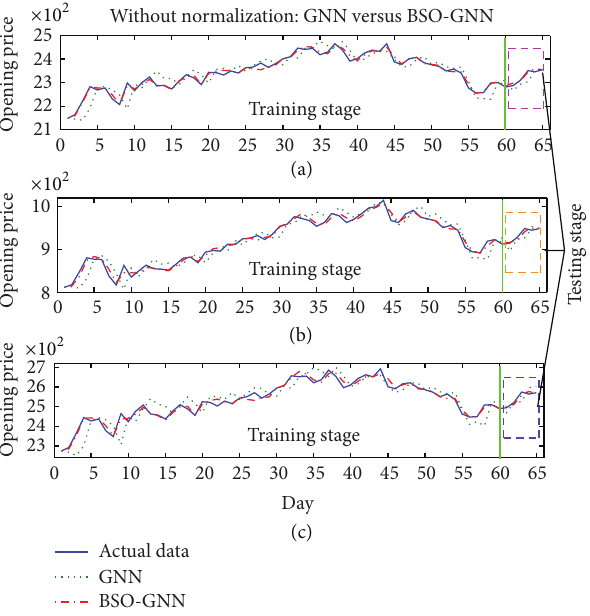
Figure 5: Opening price fitting and forecasting results of the three stock market indices gained by the individual GNN model and the BSO-GNN model under the normalization situation: (a) SSE Composite Index, (b) Shenzhen Composite Index, and (c) HuShen 300